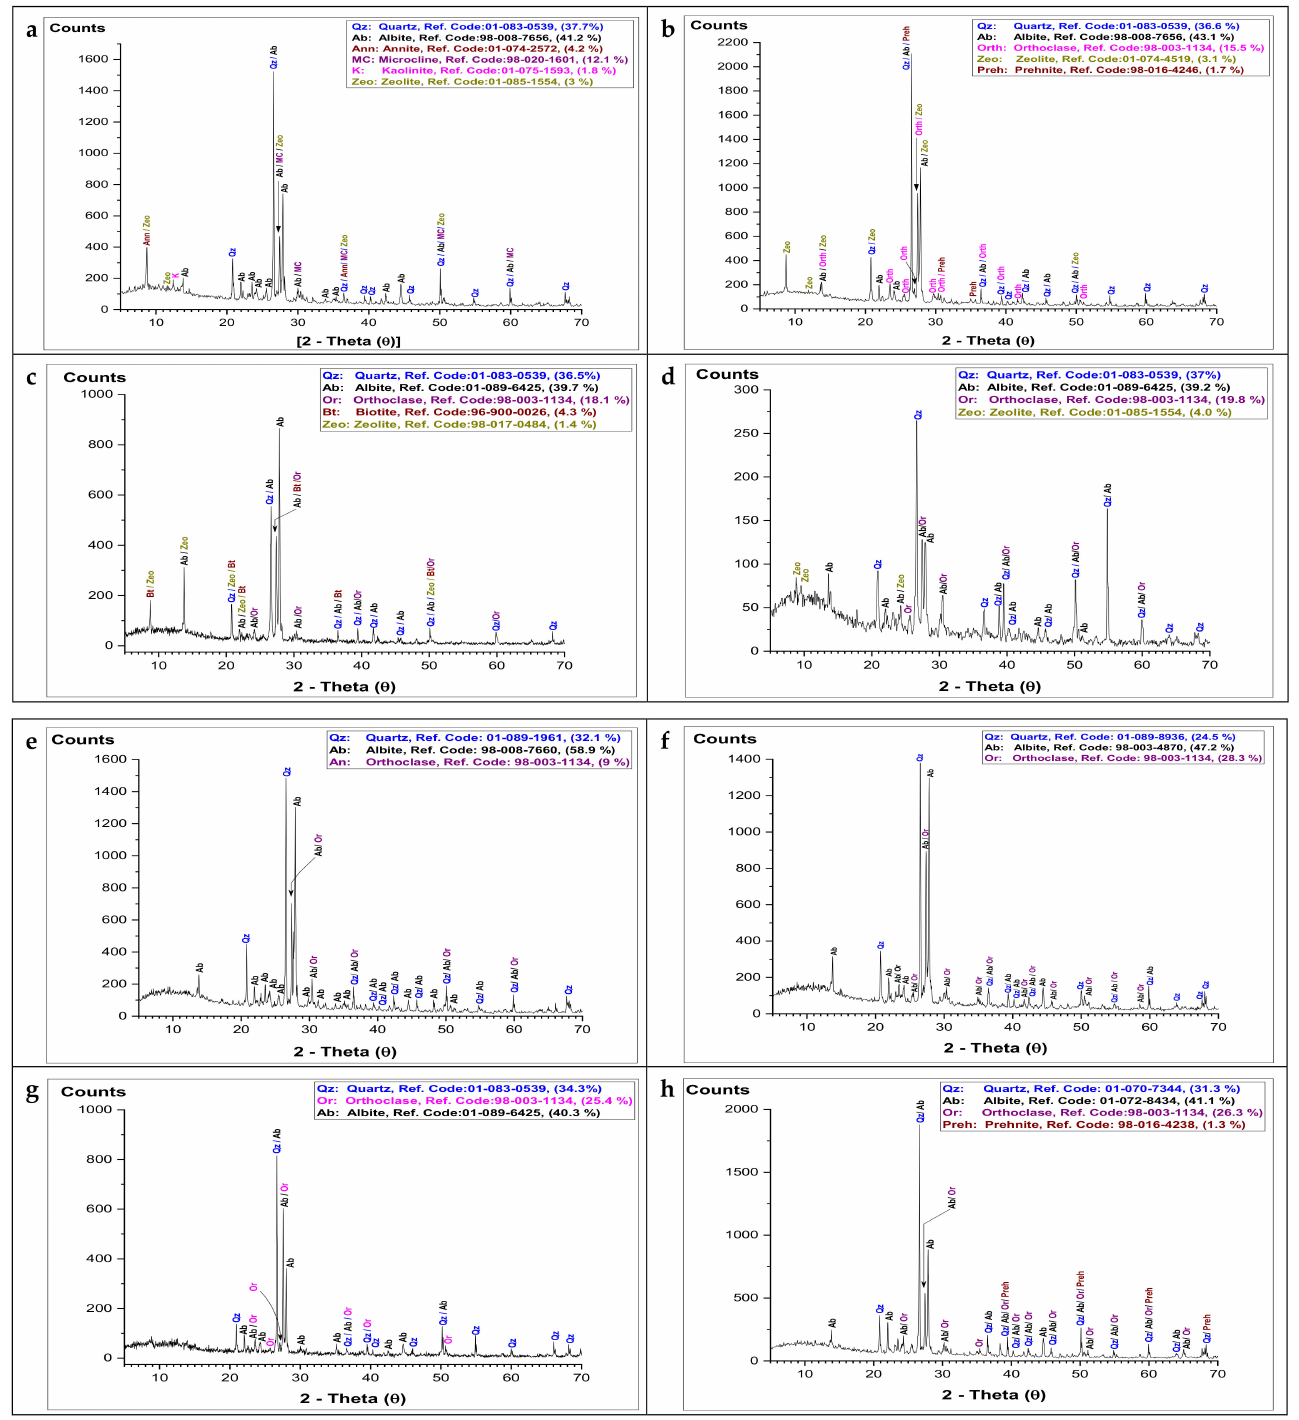
Figure 5. X-ray diffraction (XRD) patterns showing the main mineralogical composition of different granitic rocks: ( a ) Gandonna; ( b ) pink granite; ( c ) buff graniteI; ( d ) buff graniteII; ( e ) Fantazia; ( f ) red granite; ( g ) Rosa granite; ( h ) Qusseir